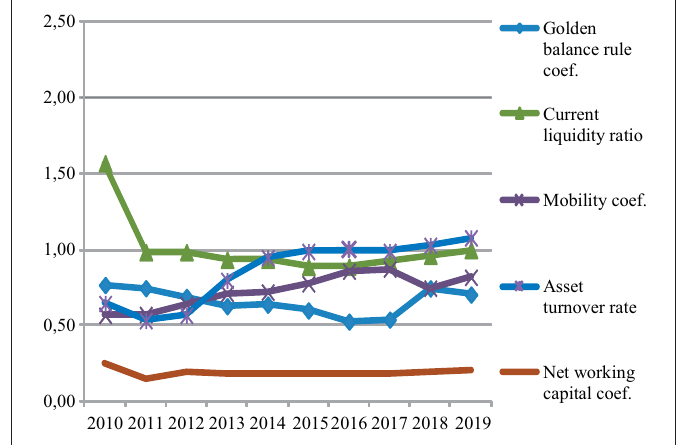
Fig. 7. Dynamics of financial leverage indicators of the enterprise provided